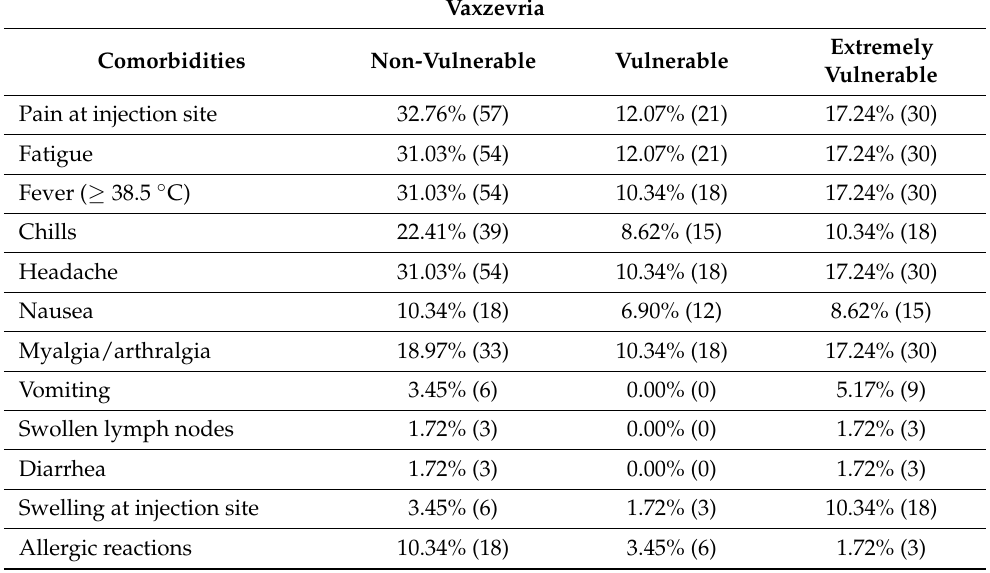
Table 4. Adverse events by comorbidities for Vaxzevria and